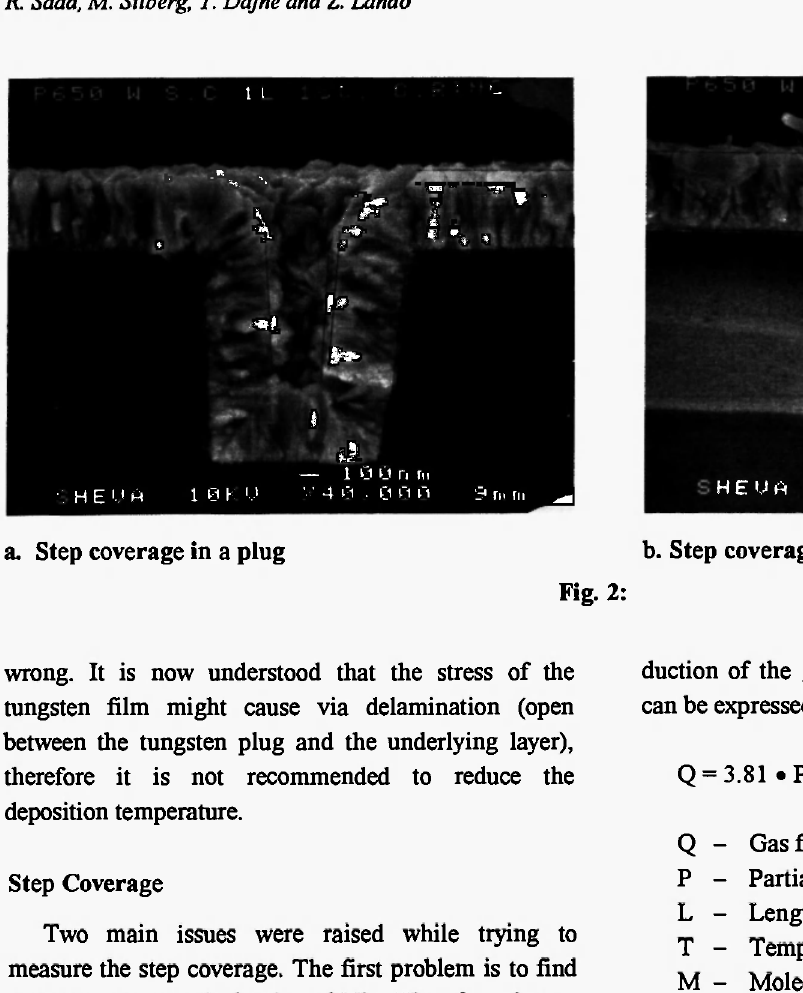
b. Step coverage in a guard